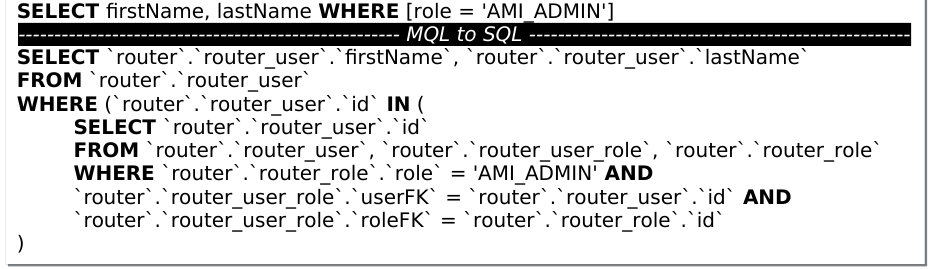
Fig. 5. Conversion of a MQL (at top) query to a complex SQL query (at